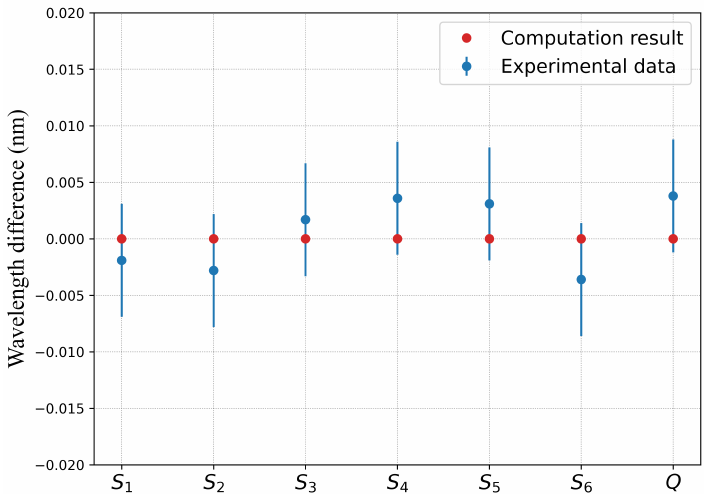
Figure 6. Bragg wavelength difference between the experimental data and the computations corre- sponding to the control points for FBG #2 without over-clad.